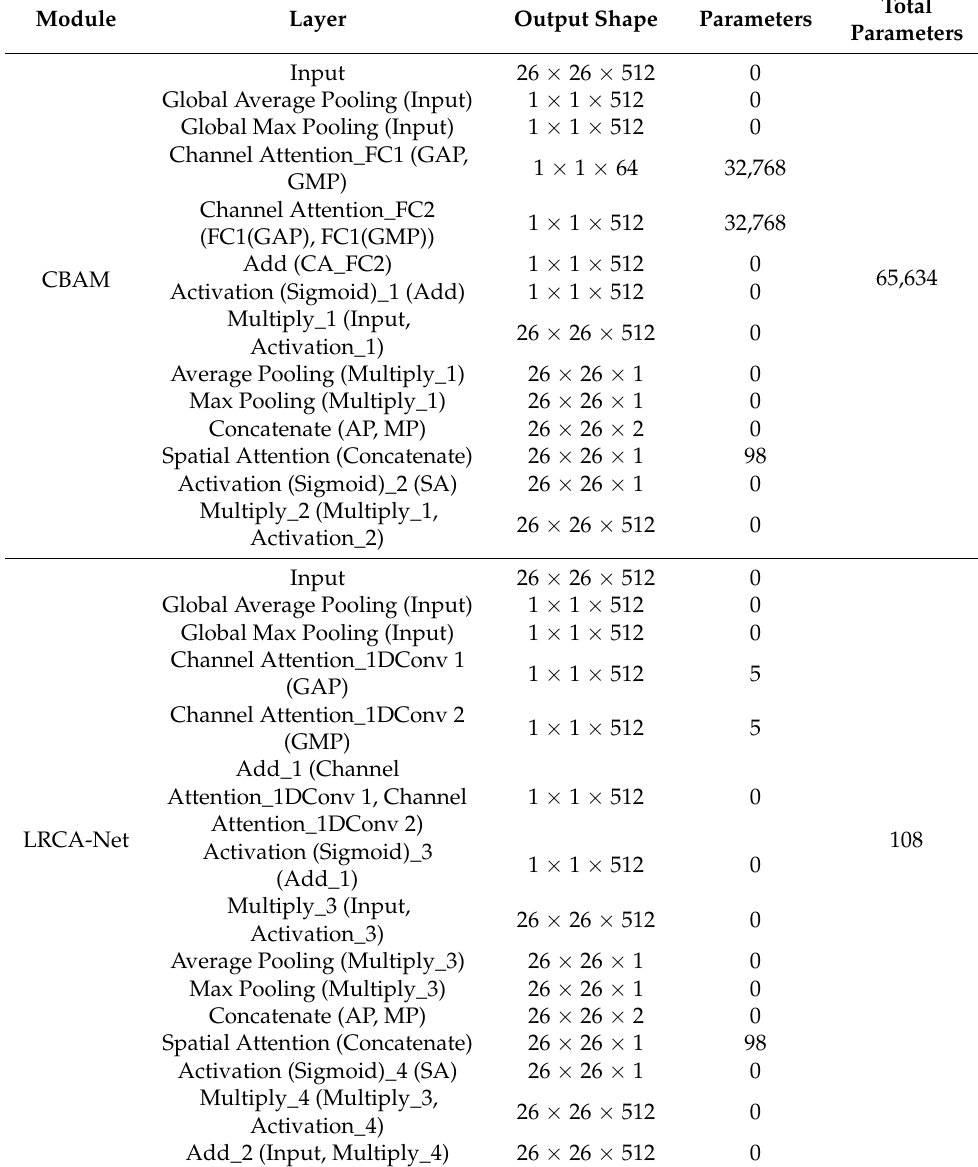
Table 1. Structure and parameters of CBAM and